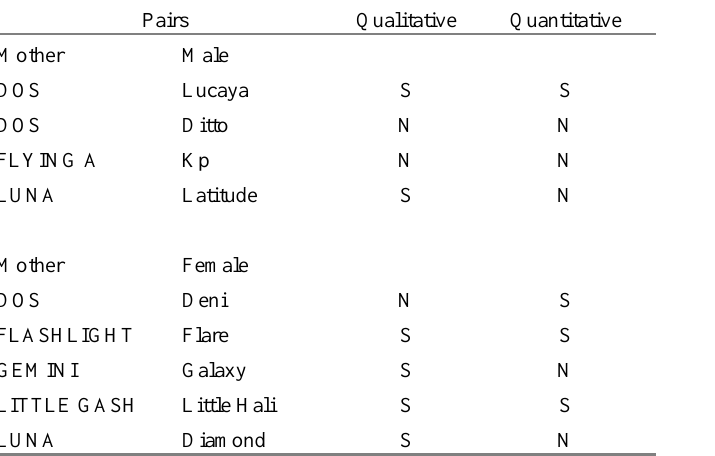
Similarity Summary Table by Qualitative (contour similarity by judge scoring) and Quantitative Methods (number of similar